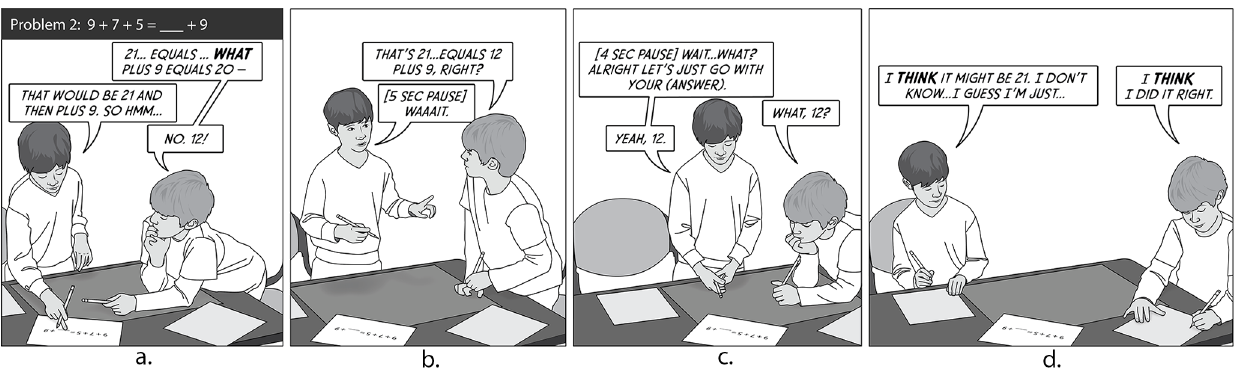
Figure 2. Synoptic Comic Strip of Dylan (Left) and Shawn (Right) Working on Problem 2. From Alibali, Gutiérrez, & Brown (2017), under a CC-BY4.0